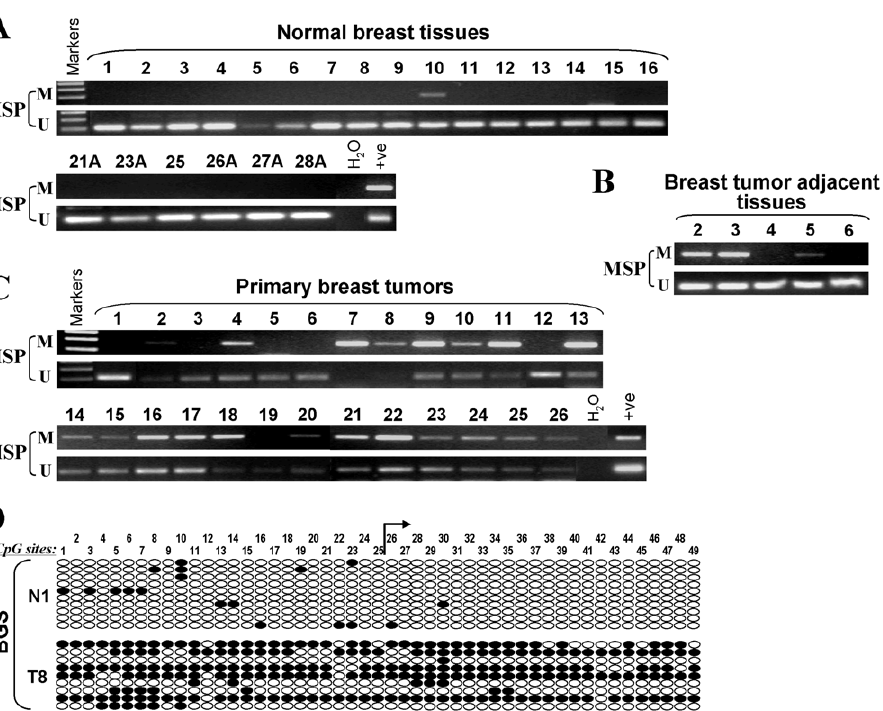
Figure 3. Promoter methylation of UCHL1 in primary breast tumors. (A, B, C) Representative analysis of UCHL1 methylation by MSP in normal breast tissues, breast tumor adjacent tissues and primary tumors. M, methylated; U, unmethylated. (D) Detailed BGS analysis of UCHL1 promoter in primary tumor and normal breast tissue. Circles, single CpG sites analyzed; row of circles, individual promoter allele cloned, randomly selected and sequenced; Filled circle, methylated; empty circle, unmethylated.